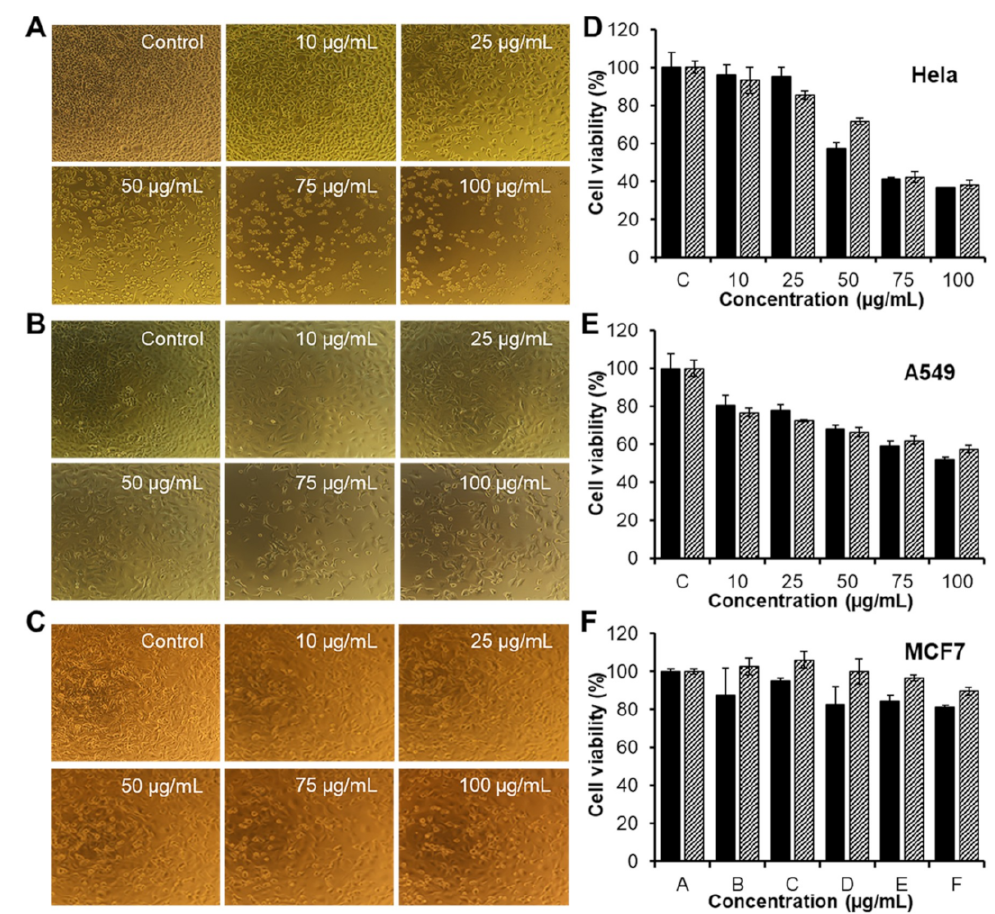
Figure 8. ( A ) Image of Hela cells, ( B ) A549 cells, and ( C ) MCF7 cells incubated with free CAR and CAR / PAMAM G3.0@mPEG at di ff erent concentration observed under microscope for 48 h. ( D ) Viability of HeLa cells, ( E ) A549 cells, and ( F ) MCF7 cells incubated with free CAR (black) and CAR / PAMAM G3.0@mPEG (diagonal) at various doses (10–100 µ g / mL) for 48 h, determined by Resazurin assay. Data are expressed as mean ± SD ( n =